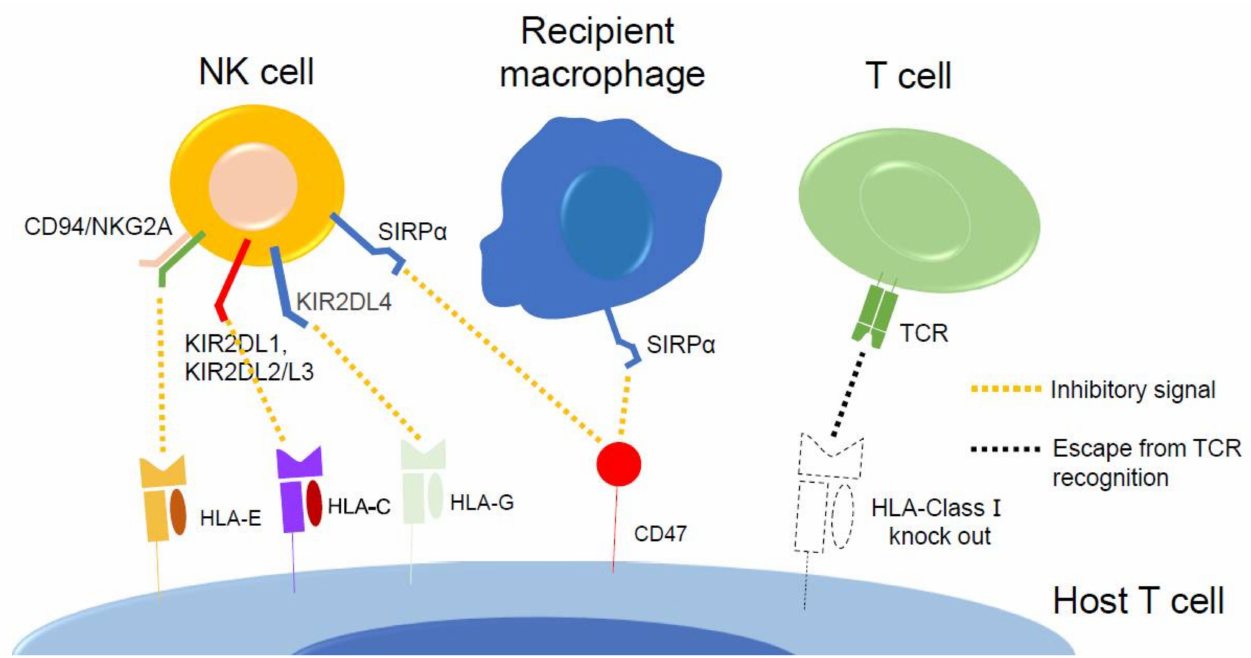
Figure 3. CRISPR/Cas9 gene editing of iPSCs can reduce immune rejection by recipient cells. Deletion of HLA class I by B2M knock out prevents T cell rejection. HLA-C and HLA-E protect against NK cell “missing self” response. NK cell attack can also be blocked by the overexpression of